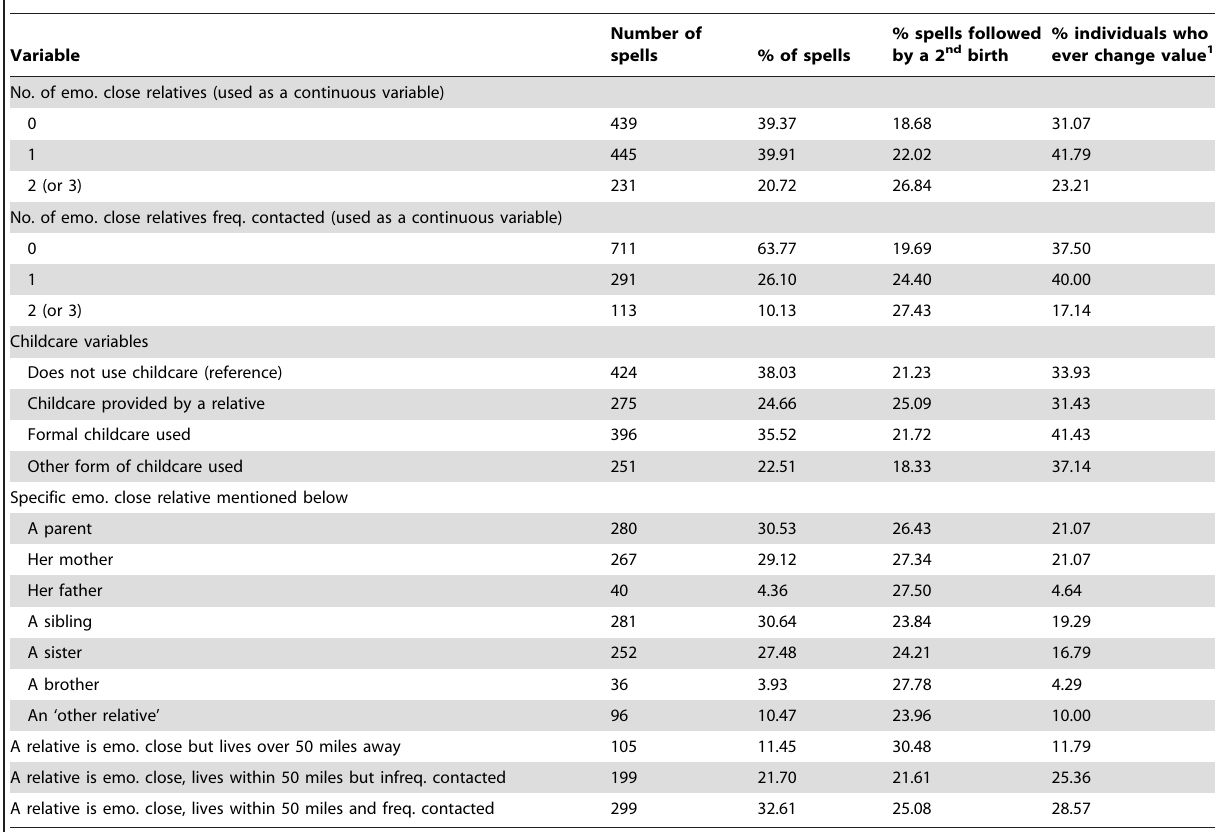
Table 1. Descriptive statistics of explanatory